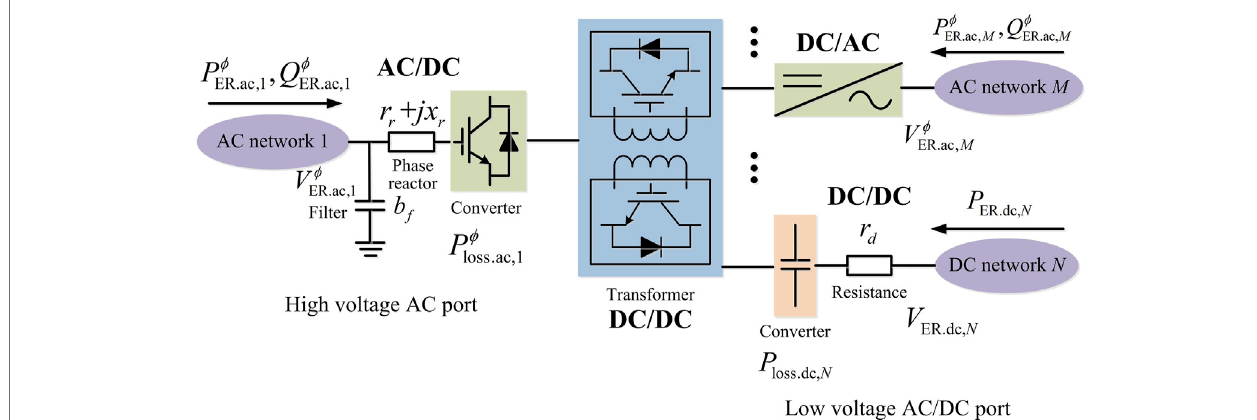
FIGURE 1 | Equivalent structure diagram of ER.